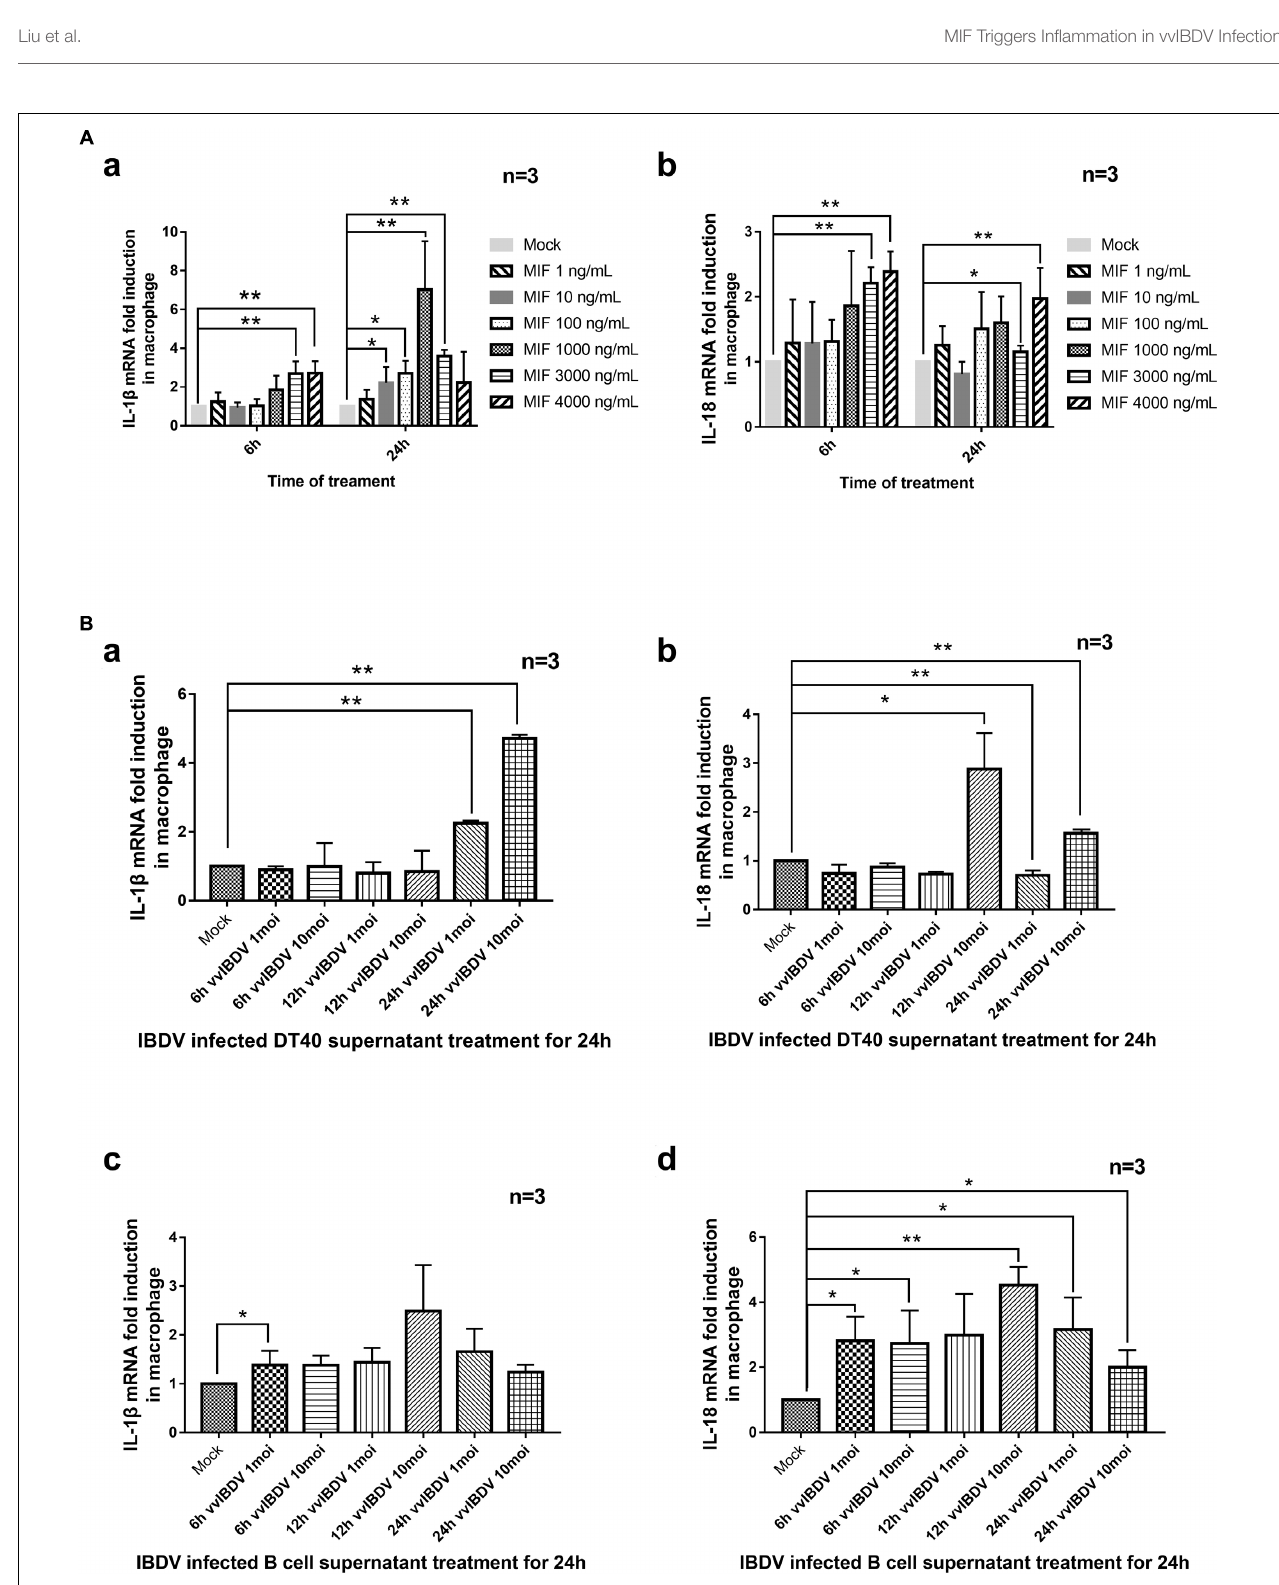
FIGURE 5 | Transcription of proinflammatory cytokines was mediated by chicken macrophage migration inhibitory factor (chMIF) and very virulent infectious bursal disease virus (vvIBDV)-infected DT40 and bursal cell supernatants. (A) Primary macrophages were isolated and treated with different concentrations (0, 1, 10, 100, 1,000, 2,000, 3,000, or 4,000 ng/ml) of chMIF for 6 or 24 h and then subjected to quantitative polymerase chain reaction (qPCR) for analysis of transcription levels of interleukin (IL)-1 β (a) and IL-18 (b) . (B) Primary macrophages were treated with vvIBDV or mock-infected DT40 or bursal cell supernatants for 24 h, followed by determination of the transcription levels of (a,c) IL-1 β and (b,d) IL-18. ∗ P < 0.05 and ∗∗ P < 0.01 compared with control groups.